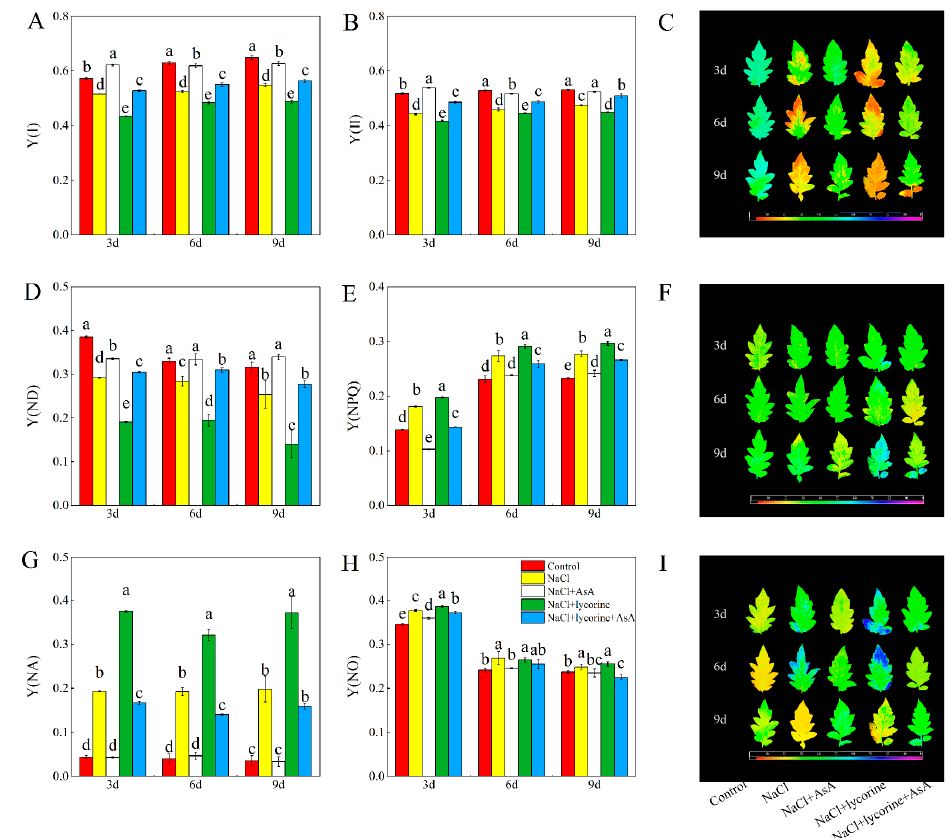
Figure 2. Values of the effective quantum yield of PSI (Y(I)) ( A ), effective quantum yield of PSII (Y(II)) ( B ), false-color images of Y(II) ( C ), fraction of over P700 that is oxidized in a given state (Y(ND)) ( D ), the quantum yield of regulated non-photochemical energy dissipation of PSII (Y(NPQ)) ( E ), false-color images of Y (NPQ) ( F ), fraction of over P700 that cannot be oxidized in a given state (Y(NA)) ( G ), the quantum yield of non-regulated energy dissipation of PSII (Y(NO)) ( H ), and false-color images of Y(NO) ( I ) in leaves of salt-stressed tomato seedlings with or without exogenous reduced ascorbic acid (AsA) and lycorine (AsA synthesis inhibitor) spraying. Abbreviations 3d, 6d, and 9d represent the third, sixth, and ninth day after treatment, respectively. Control, no added NaCl and sprayed with distilled water; NaCl, added 100 mmol·L –1 NaCl and sprayed with distilled water; NaCl + AsA, added 100 mmol·L –1 NaCl and sprayed with 0.5 mmol·L –1 AsA; NaCl + lycorine, added 100 mmol·L –1 NaCl and sprayed with 0.25 mmol·L –1 lycorine; NaCl + lycorine + AsA, added 100 mmol·L –1 NaCl and sprayed with 0.25 mmol·L –1 lycorine plus 0.5 mmol·L –1 AsA. Values are means ± SD ( n = 3). Values with a different letter within a sampling date are significantly different ( p < 0.05).